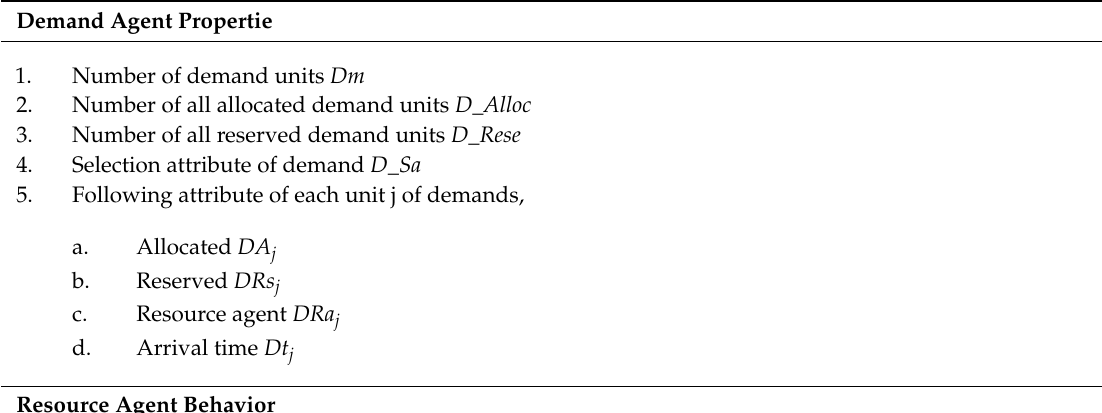
Table 2. Demand agent